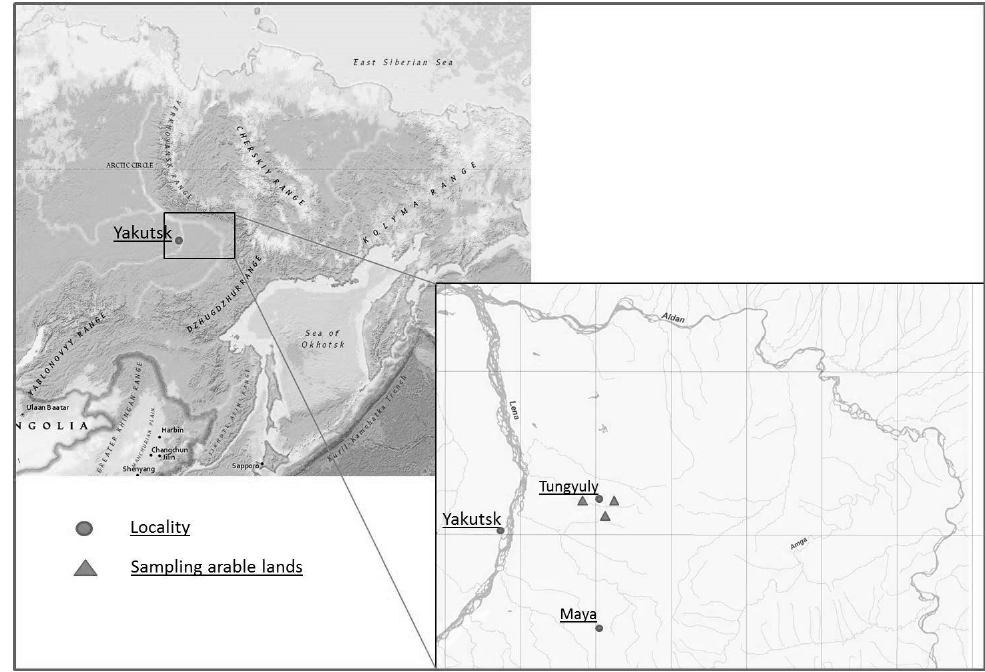
Figure 2. Study area between Lena and Aldan rivers.